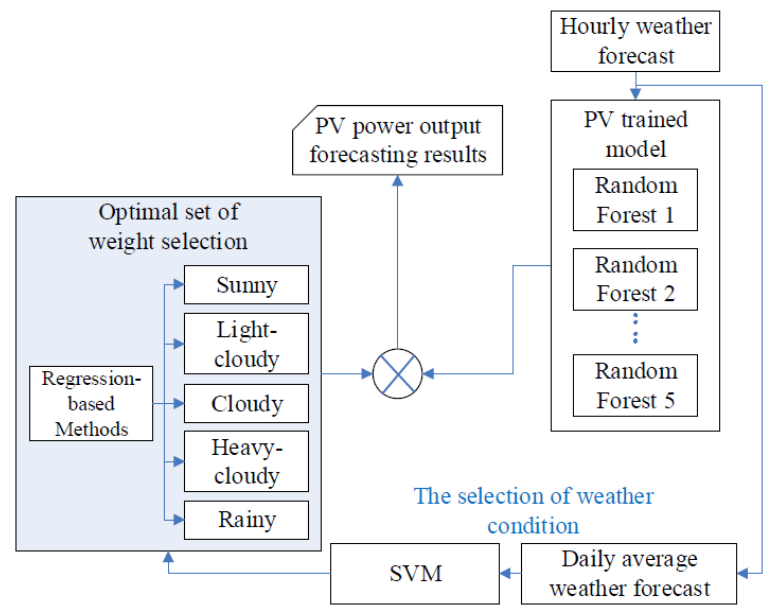
Figure 6. The detailed process of step 3.